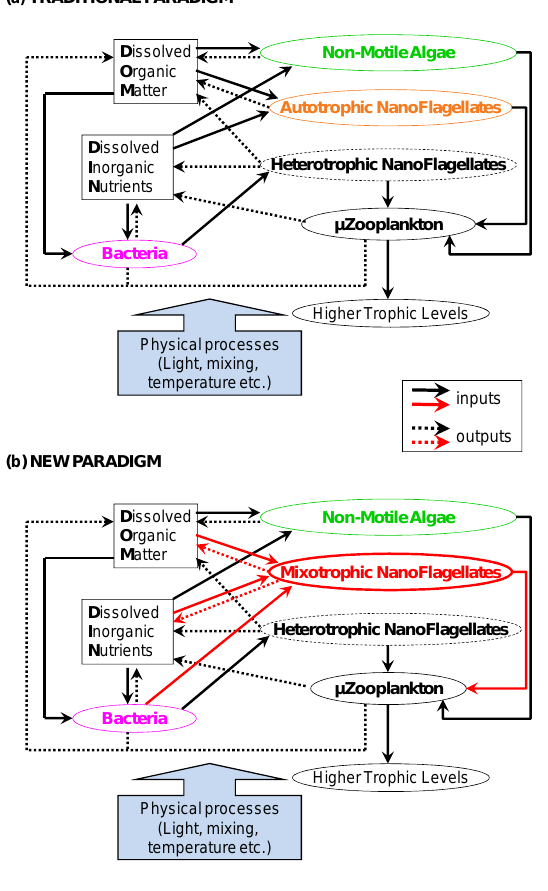
Fig. 2. Schematic representing the two alternate modelled food web structures. In the traditional paradigm (A) the physiology of the photoautotrophic flagellates (ANFs) is similar to that of the non- motile microalgae (NMA); neither are mixotrophic. Inorganic nutri- ents for the support of primary production are regenerated via bac- teria, heterotrophic nanoflagellates (HNFs) and phagotrophic mi- crozooplankton (µZ). In the new paradigm (B) , the ANFs are re- placed with mixotrophic nanoflagellates (MNFs), conforming to our present understanding of protist physiology. The MNFs are capable of eating bacteria (red-lined black arrow), and hence deriving nu- trients for the support of their growth, and of their primary produc- tion, directly rather than (for ANFs in panel A ) via the activities of HNFs + µZ. Dashed arrows indicate functions contributing to nu- trient pools (blue for inorganic, brown for organic). Heavy black arrows indicate predatory